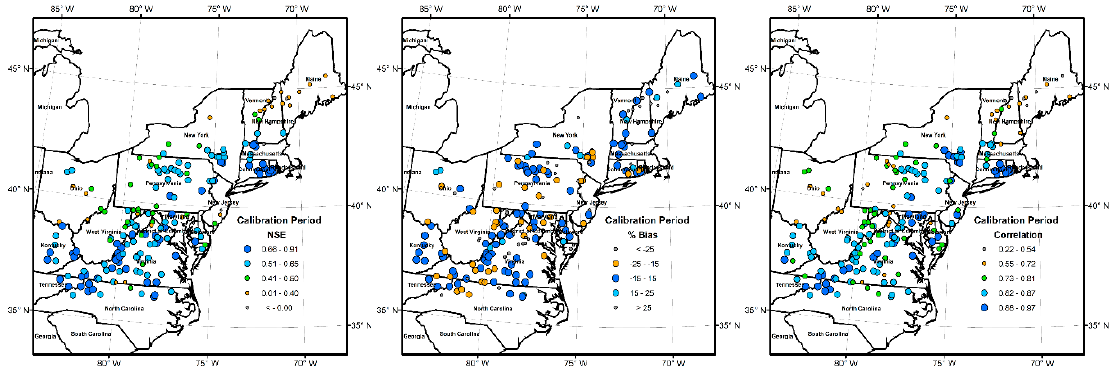
Figure 3. Nash Sutcliffe efficiency, percentage bias and correlation of smoothed daily streamflow for the calibration year 1980.